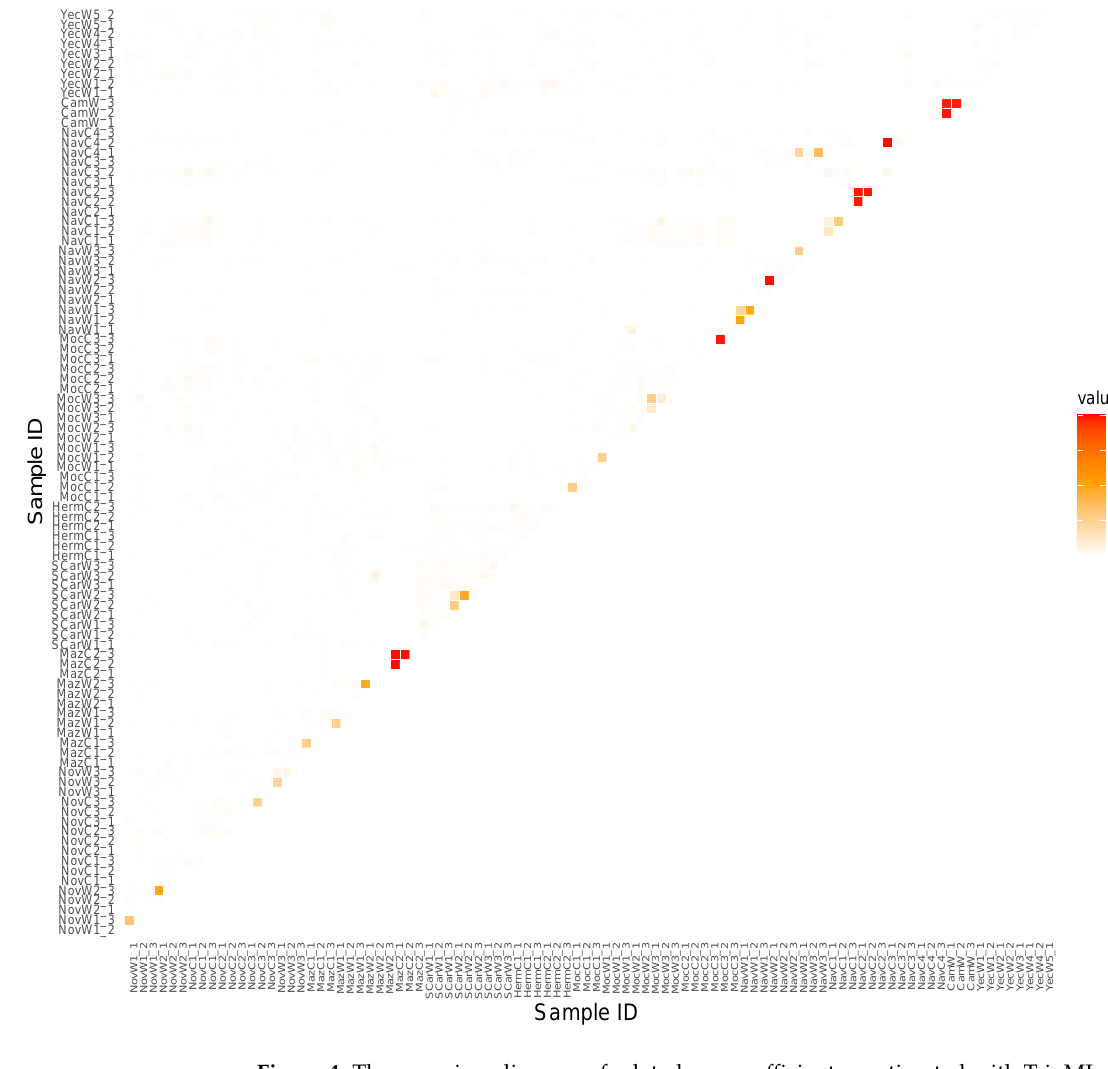
Figure 4. The overview diagram of relatedness coefficient as estimated with TrioML methodology among 95 Agave angustifolia var. pacifica individuals from the state of Sonora, Mexico. The degree of relatedness is represented by colors, from white indicating no relationship, to red representing a clonal relationship. Samples are coded according to the Table S1. Table 1. Diversity estimates and standard deviation (in parentheses) as estimated for wild and culti- vated Agave angustifolia var. pacifica in the state of Sonora, Mexico. Wild populations were determined based on spatial analysis in TESS3R. One highly divergent wild site (Cam) is excluded from this table. N —number of individuals; sMLH—standardized multilocus heterozygosity; MLH—multilocus heterozygosity; IR—internal relatedness; Fis —Wright’s inbreeding index; Fhat3—inbreeding